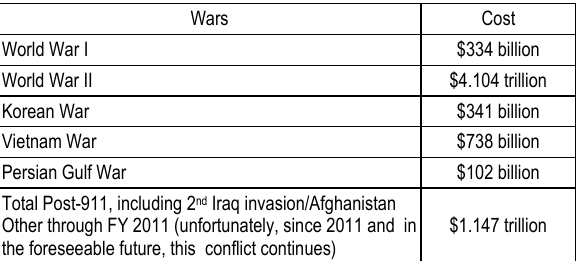
Table 1. Cost of wars from World War I to present, using constant fiscal year 2011